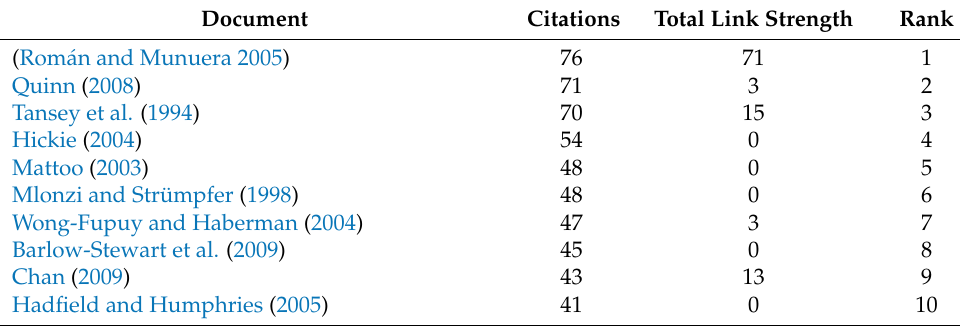
Table 4. Ten most cited articles by total